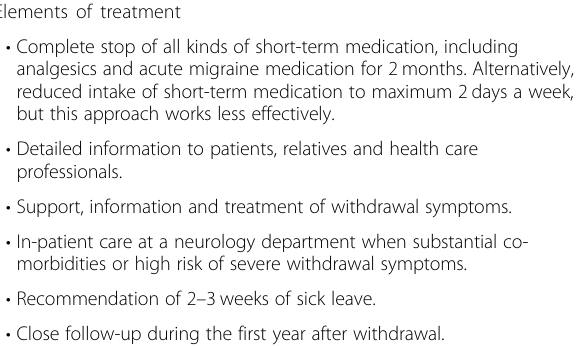
Table 17 Non-pharmacological treatment of medication overuse headache Elements of